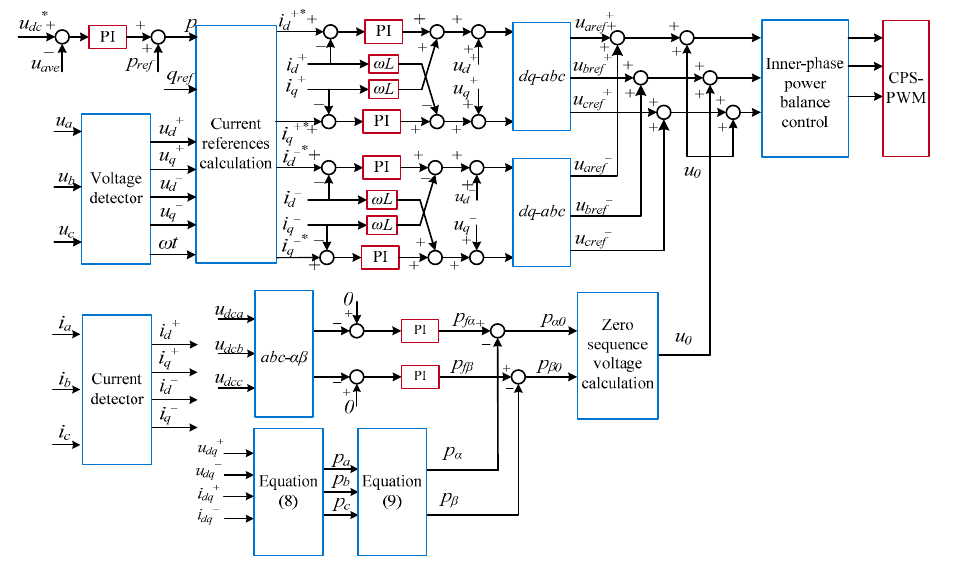
Figure 4. The power control strategy of a star-connected SVG.